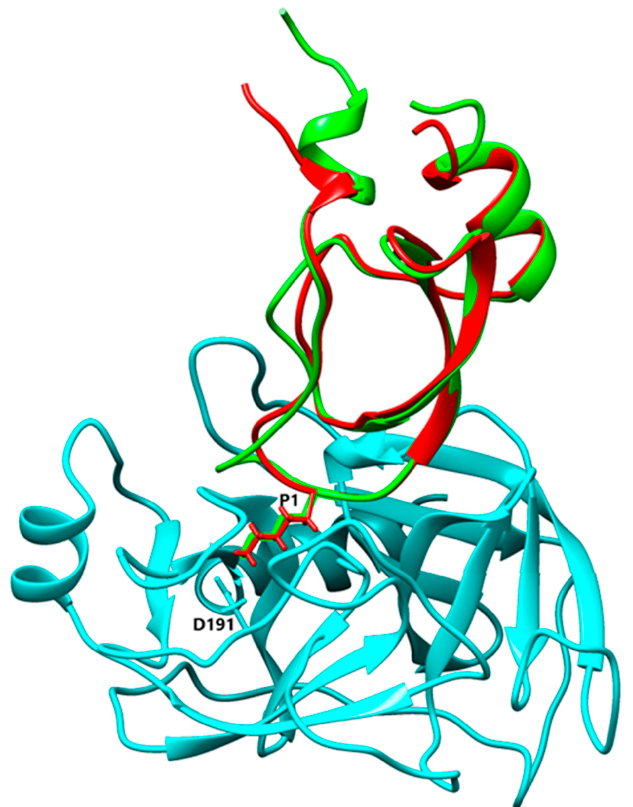
Figure 8. Alignment between Kun_Myl_17096 and Trypsin/BPTI (PBD Code 4Y0Y) [53] structures. Light blue, Trypsin; red, BPTI; green, Kun_Myl_17096. Stick representation has only been shown for Lys20 (P1) and Asp191 residues.